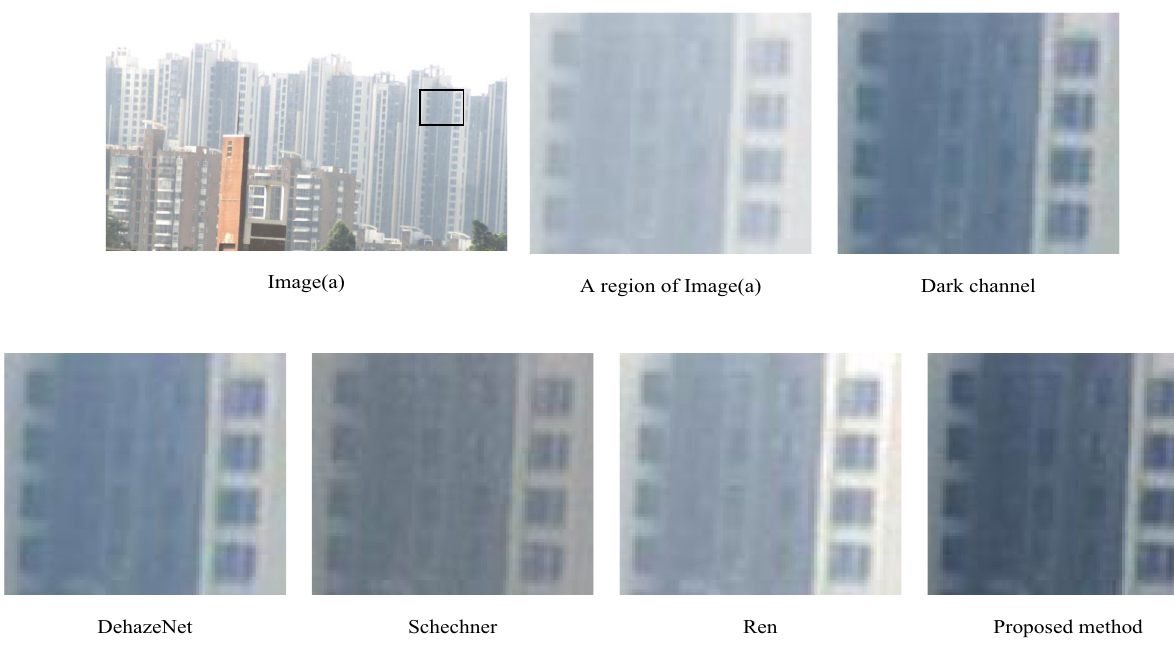
Figure 5. The same region in images ( a ), ( b ), ( c ), ( d ), ( e ), ( f ) in group 1.